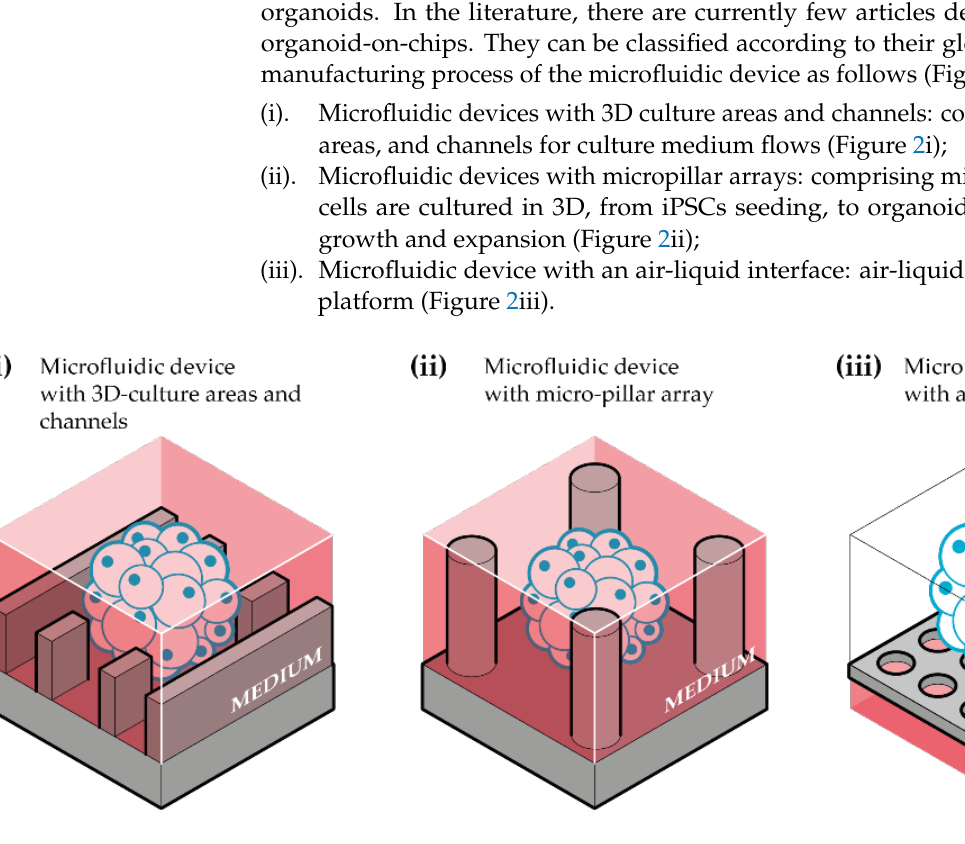
Figure 2. Schematic representation of the three main types of microfluidic devices used for brain organoid-on-chip systems. ( i ) Microfluidic device with 3D-culture areas and channels: device composed of a compartment for cerebral organoids culture, linked to channels for culture medium flow and perfusion; ( ii ) microfluidic device with micropillar array: device that contain micropillars between which cerebral organoids are generated and cultured; ( iii ) microfluidic device with air/liquid interface: device adapted to a cerebral organoid culture in an air-liquid interface.